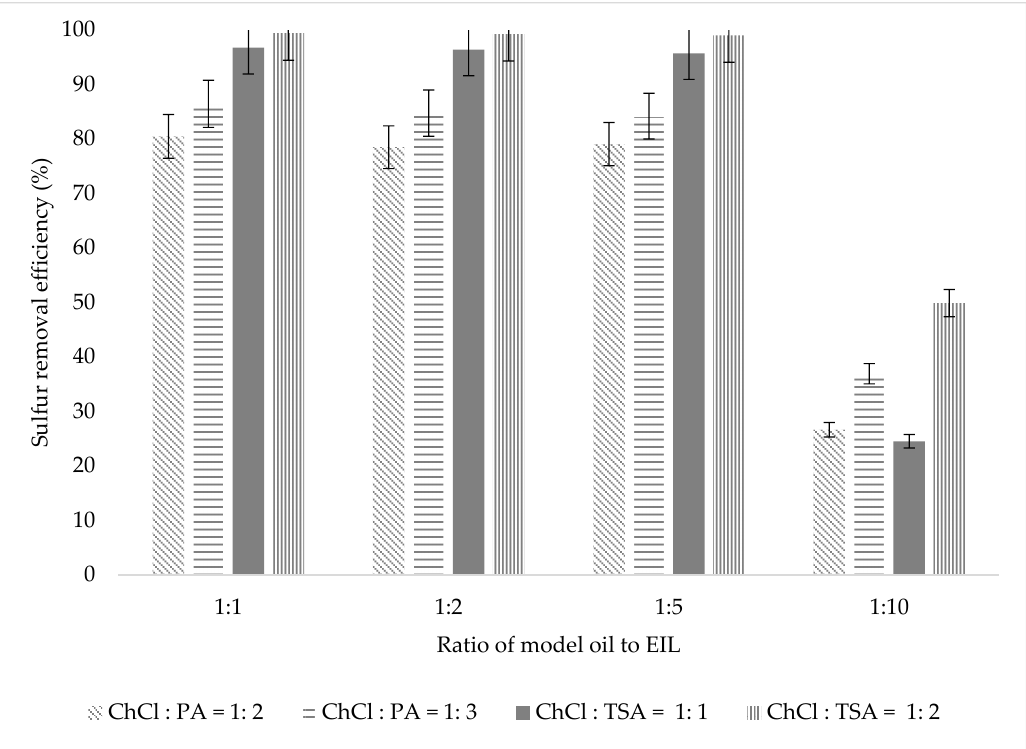
Figure 5. The effect of EIL to model oil ratio on the sulfur removal efficiency (0.01 g Cu-Fe/TiO 2 , H 2 O 2 as an oxidant with a ratio to DBT of 1:2, 10 mL of 100 ppm model oil (DBT), room temperature, and 600 rpm stirring speed).